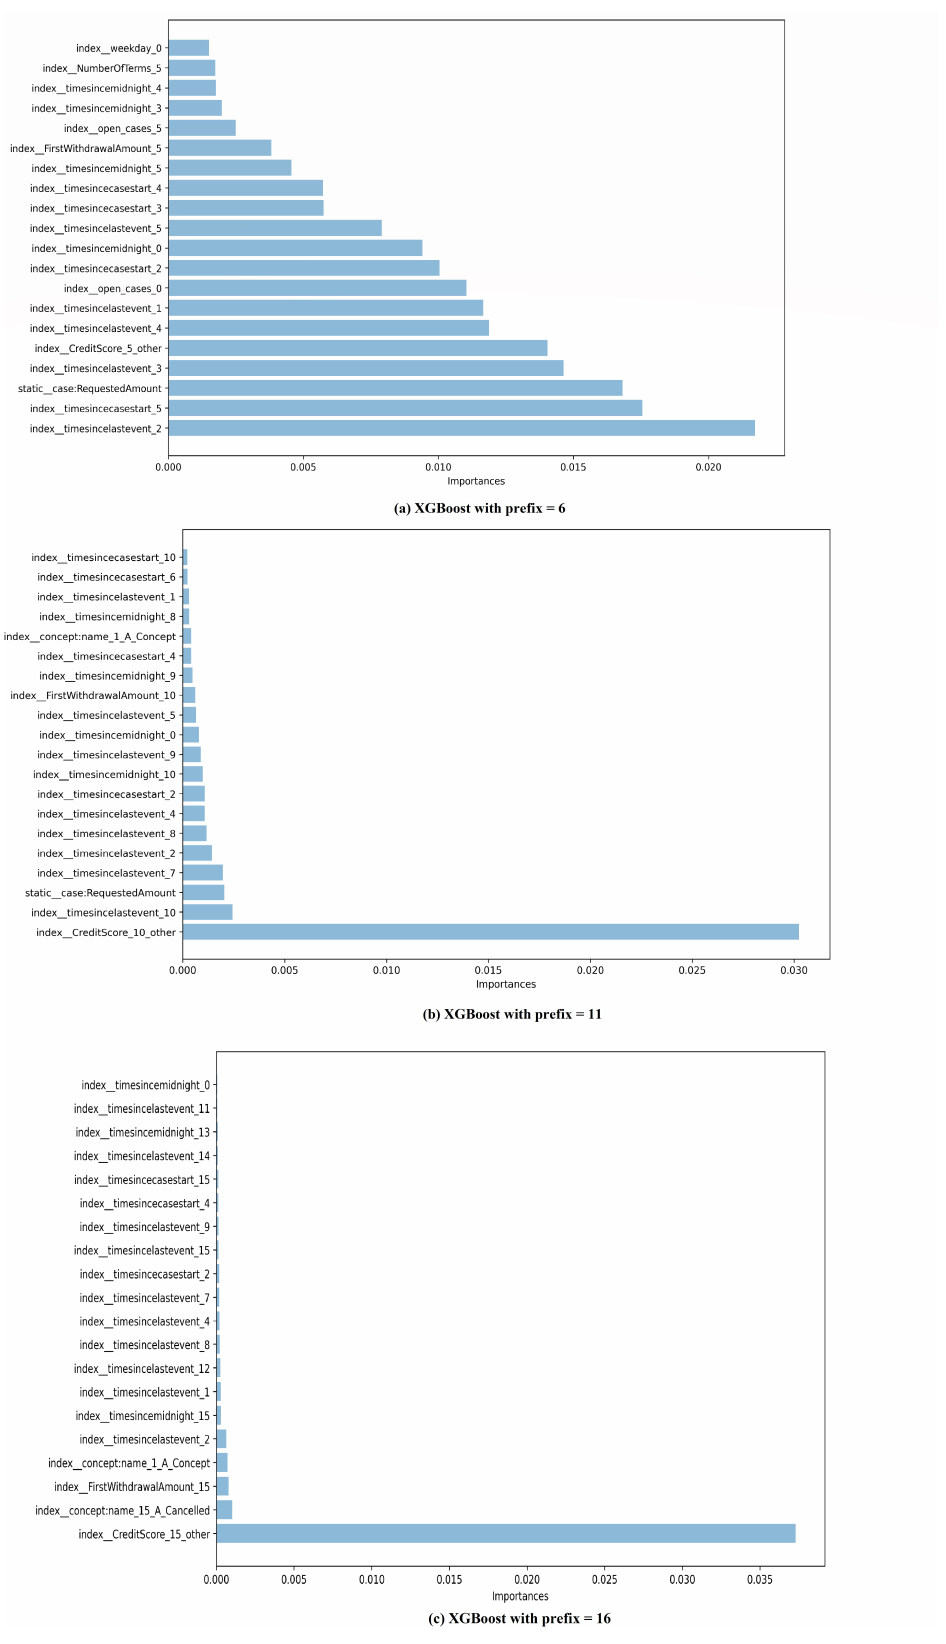
Figure 11. PFI according to XGBoost trained over BPIC2017_Refused (preprocessed with prefix index